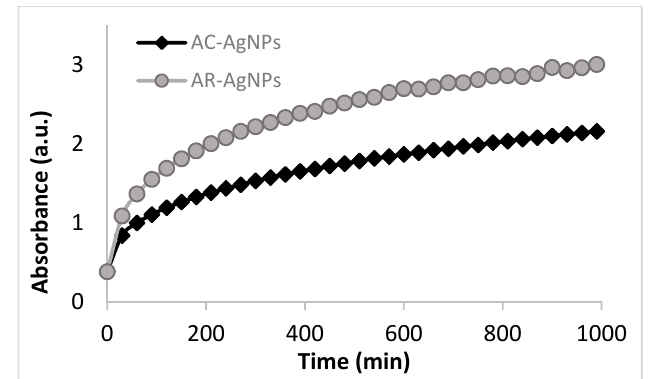
Figure 3. Change in absorbance with time during AC-AgNP and AR-AgNP formation as observed at the λ max at 413 nm and 433 nm, respectively (in water). AC: Aqueous extract subjected to organic solvent partitioning. AR: simple aqueous extraction.